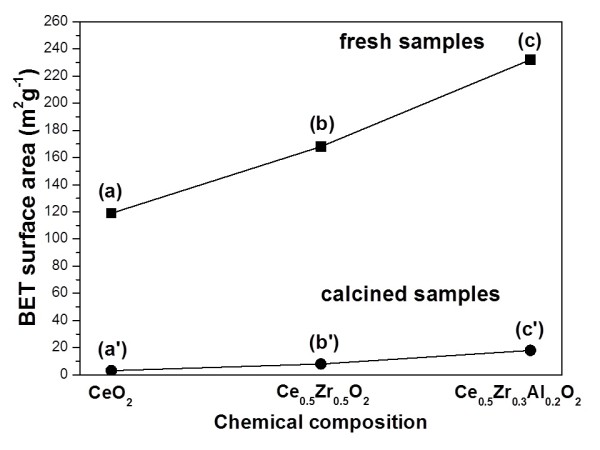
BET specific surface areas of fresh and calcined samples.  Fresh samples: (a) CeO2, (b) Ce0.5Zr0.5O2, and (c) Ce0.5Zr0.3Al0.2O1.9. Calcined samples: (a') CeO2, (b') Ce0.5Zr0.5O2, and (c') Ce0.5Zr0.3Al0.2O1.9.